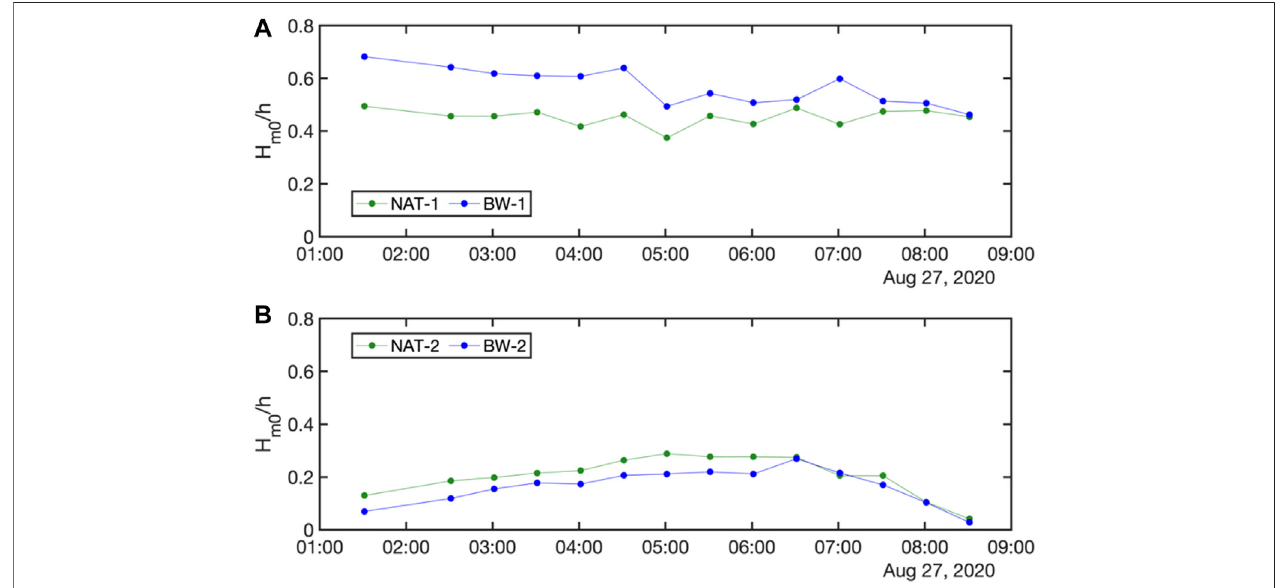
FIGURE 7 | Time series of wave height to water depth ratio at wave gauges near the shoreline, i.e., NAT-1 and BW-1 (A) , and at inland wave gauges NAT-2 and BW-2 (B) .